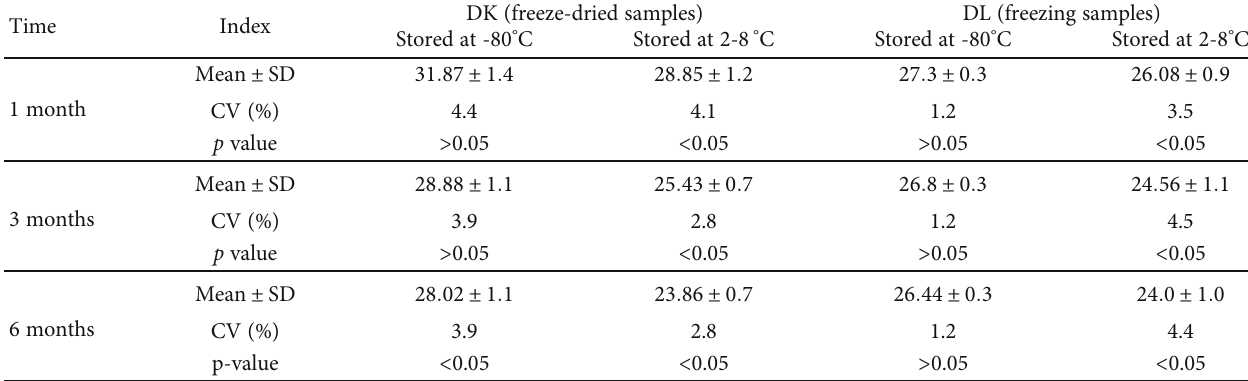
Table 4: Results of the NTU values during the study period.